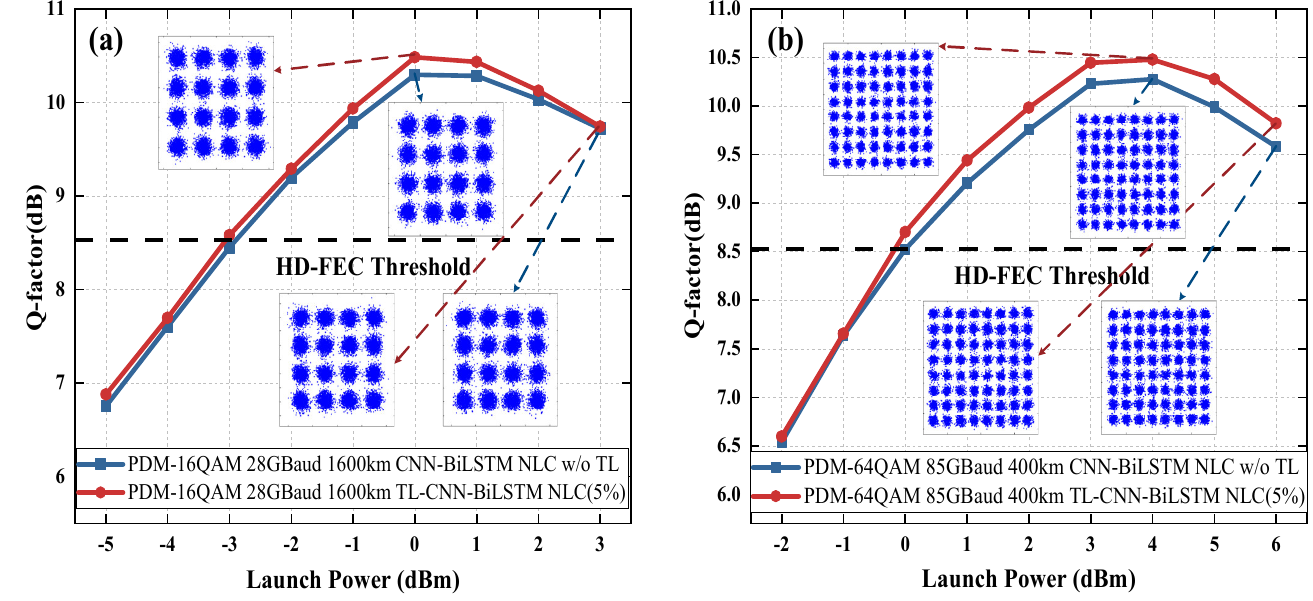
Figure 9. Q-factor of transfer learning versus retraining for different launch powers. ( a ) 28 GBaud PDM-16QAM after 1600 km transmission; ( b ) 85 GBaud PDM-64QAM after 400 km transmission.